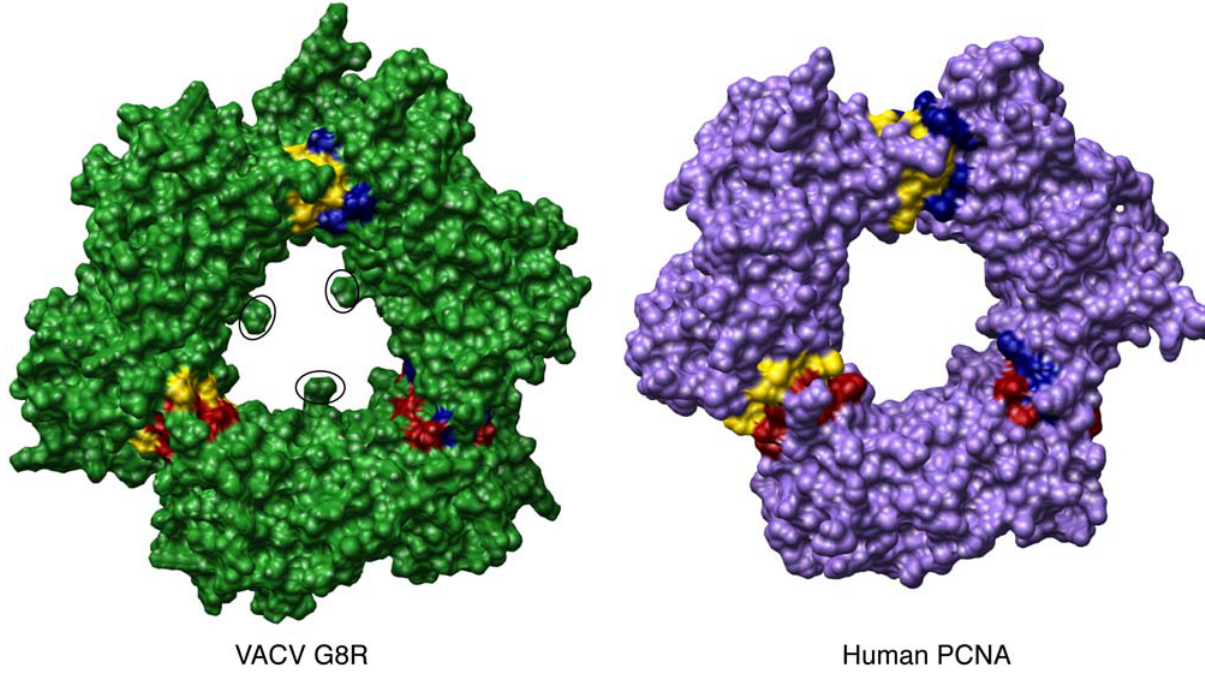
Figure 5. Surface diagrams of the VACV G8R and human PCNA trimers. Residues found to contribute to trimer stabilization and belonging to chain A of both structures are coloured in blue, chain B in yellow and chain C in red. Circles indicate the three residues on each VACV G8R monomer that protrude into the ‘‘donut hole’’ of the molecule.